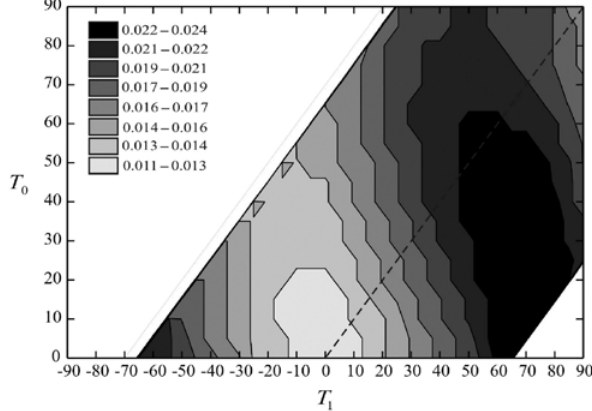
/ T 〉] Figure 8: Contour plot of Ω for the soft simply supported graphite/ 0 1 s epoxy [  〈 T / T 〉] circular 0 1 s